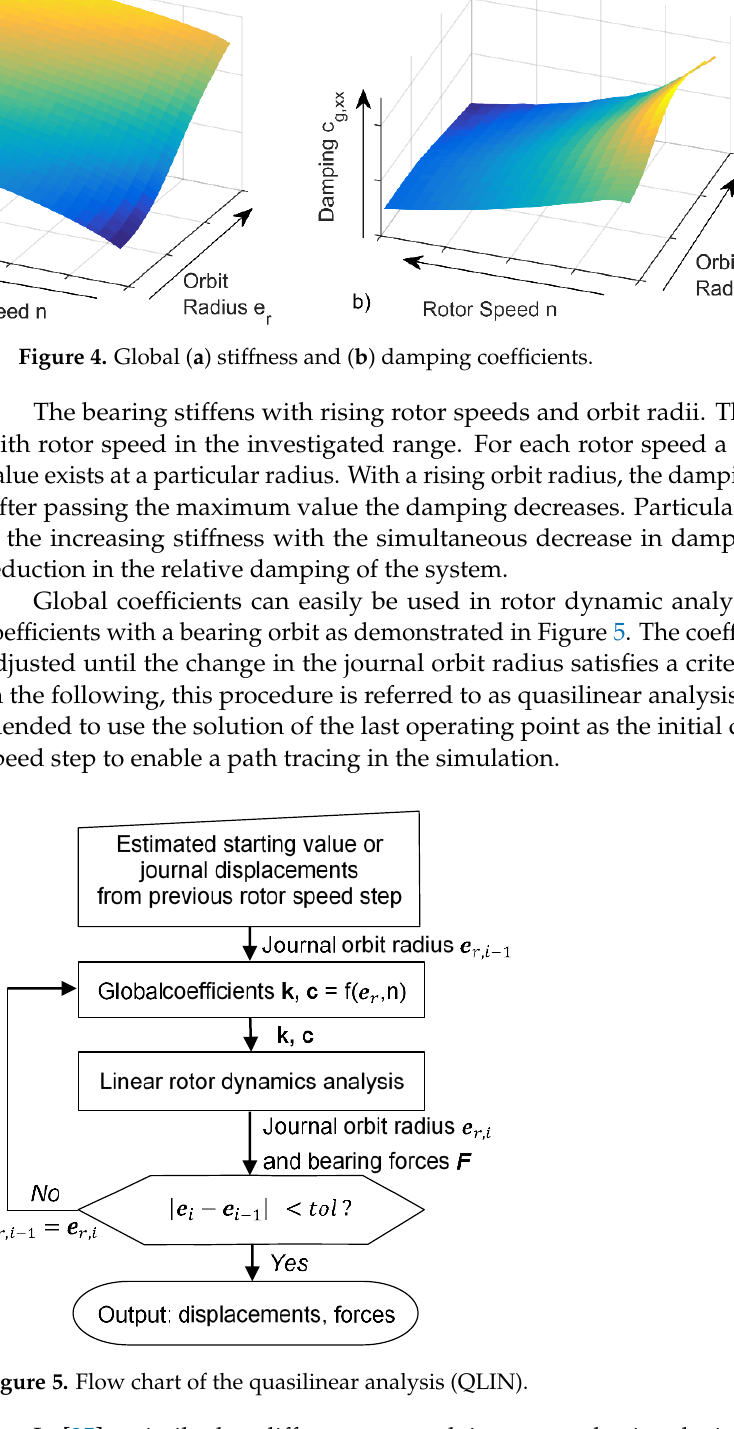
5 of 18 Figure 3. Snapshot of the kinetics of a circular orbit. The global stiffness 𝑘 𝑔,𝑟 in direction of journal orbit radius 𝑒 𝑟 and the main damp- ing 𝑐 𝑔,𝑡 in direction of tangential orbit velocity 𝑒̇ 𝑡 are calculated according to Equation (10): 𝑘 𝑔,𝑟 = 𝐹 𝑟 𝑒 𝑟 ,